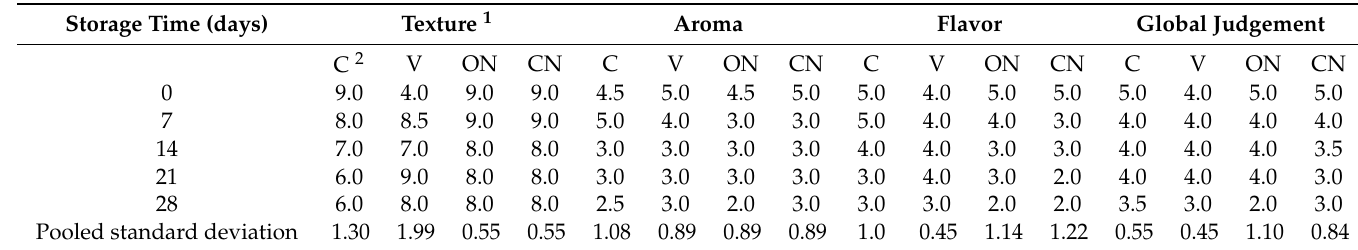
Table 3. Sensory characteristics (texture, aroma, and flavor) of fresh sample of T. melanosporum initially (0) and at 7, 14, 21, and 28 days of storage at 4 ◦ C in modified atmosphere. All data are expressed as the mean of three determinations (three tru ffl es per batch evaluated by 7 judges). Sporadically perceived sensory attributes were not